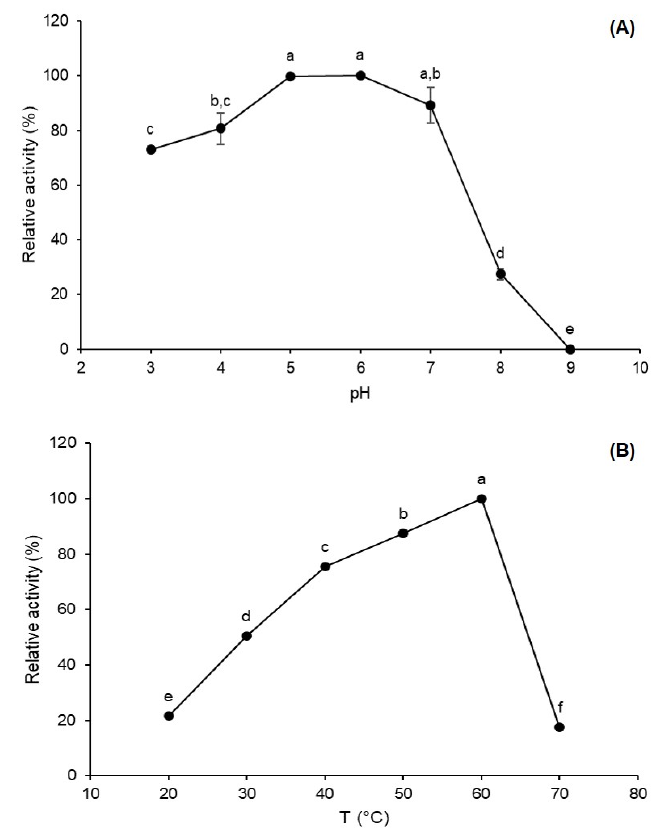
Figure 3. Effect of pH ( A ) and temperature ( B ) on FFase from A. tamarii Kita UCP 1279 obtained by solid-state fermentation using a mixture of wheat and soy bran as substrate. Different letters (a–f) indicate significant differences ( p < 0.05).